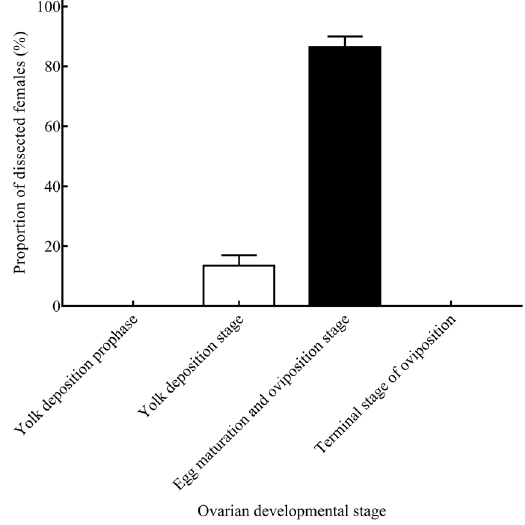
Figure 5. Proportion of female adults (%) in different stages while mating.